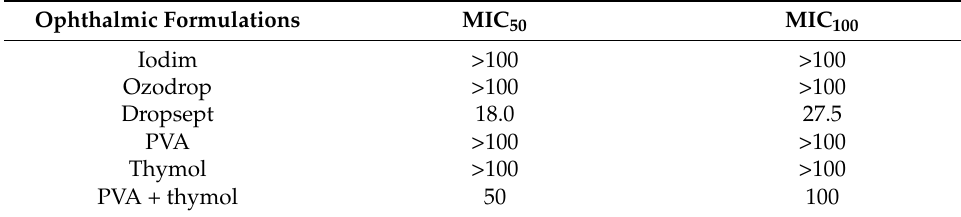
Table 3. S. epidermidis MIC 50 and MIC 100 .